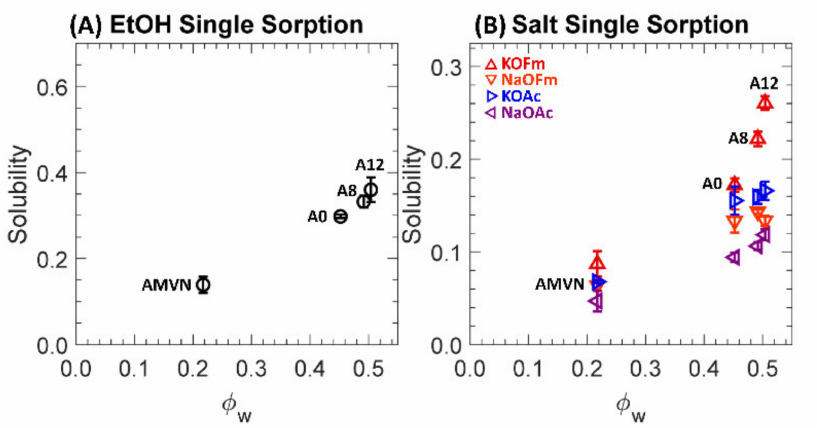
Figure 7. ( A ) Solubilities to EtOH, , in single sorption. ( B ) Solubilities to KOFm ( (cid:52) , red), NaOFm (cid:35) ( (cid:53) , orange), KOAc ( (cid:46) , blue) and NaOAc ( (cid:47) , purple) in single sorption. Each data point is the average of 3 experiments, with error bars corresponding to the standard deviation.